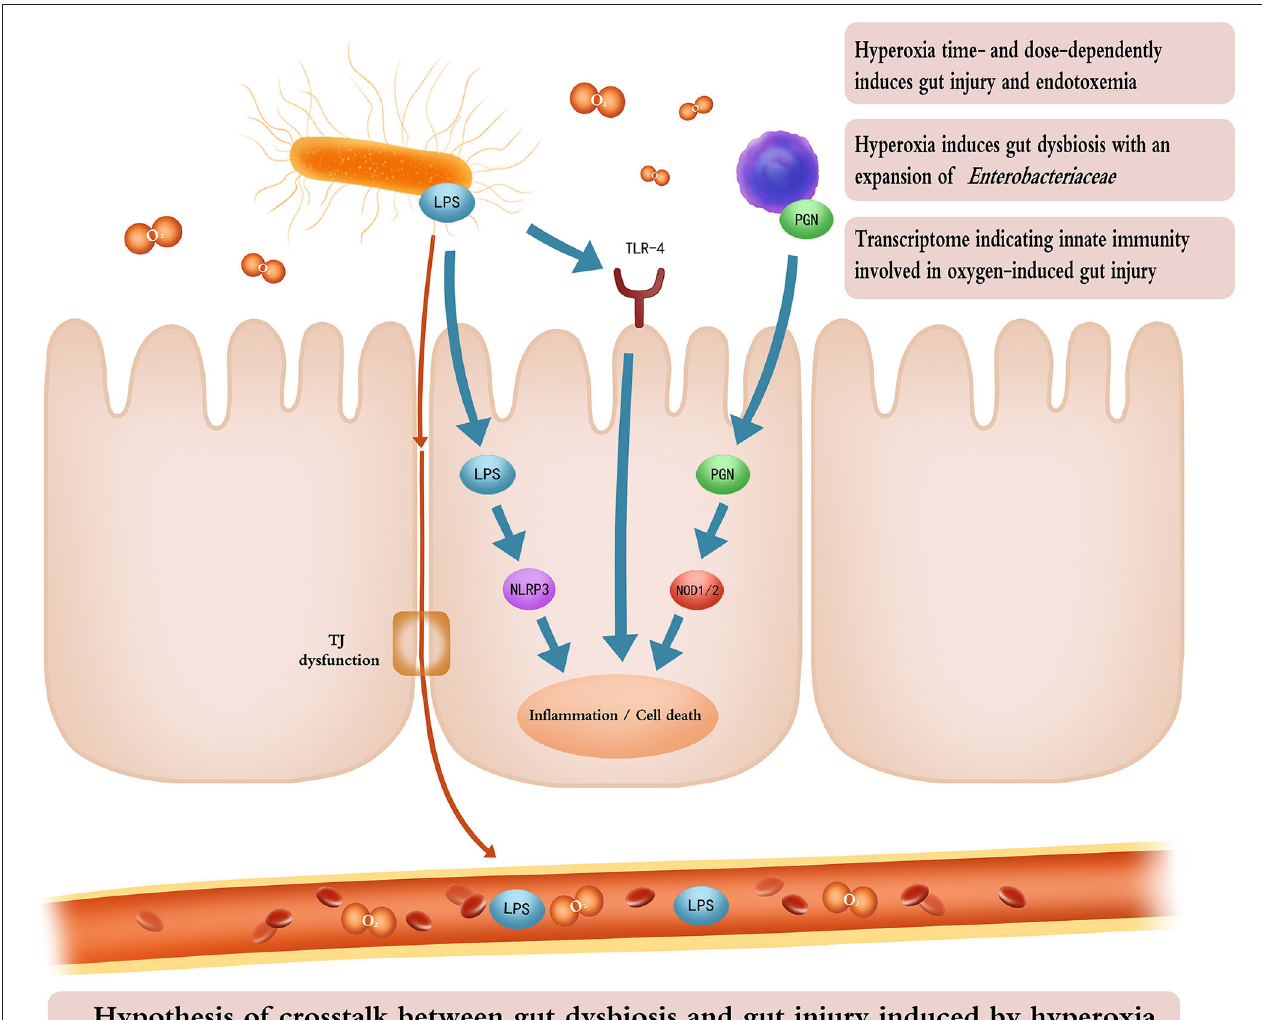
FIGURE 8 | Cartoon illustrating the hypothesis of crosstalk between gut dysbiosis and gut injury induced by hyperoxia. Time- and dose-dependent hyperoxia induces intestinal inflammation and enterocyte death and TJ dysfunction. Inhaled oxygen promotes the expansion of Enterobacteriaceae which releases LPS through impaired TJ into the bloodstream, resulting in endotoxemia. LPS from gram-negative bacteria and PGN from gram-positive bacteria activate innate immunity (TLR-4, NLRP3, and NOD signaling pathways), leading to gut inflammation and cell death. The cartoon was painted by Yuxin Wang for this study. TJ, tight junction;